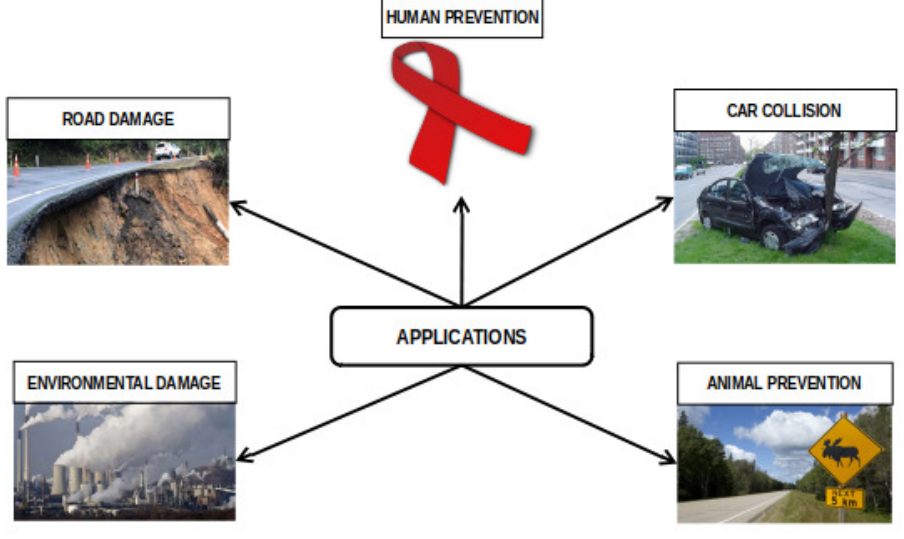
Figure 8. Summary to justify the applicability of the proposed